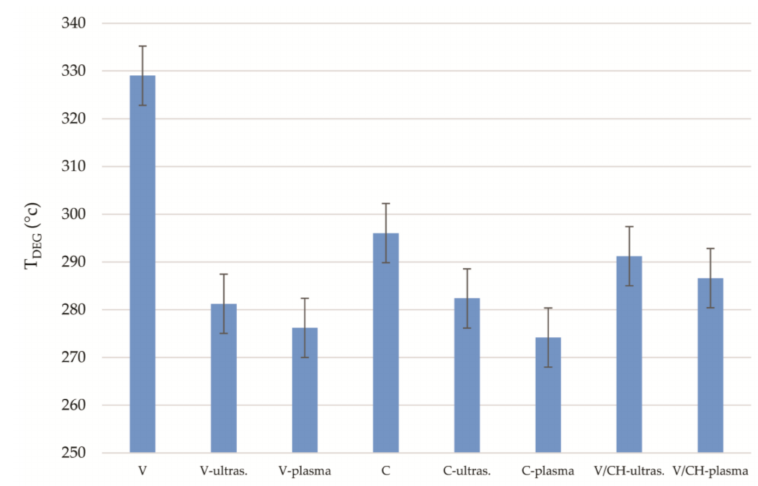
Figure 4. Temperature of thermal degradation ( T deg ) for the fibers, with the standard deviation.